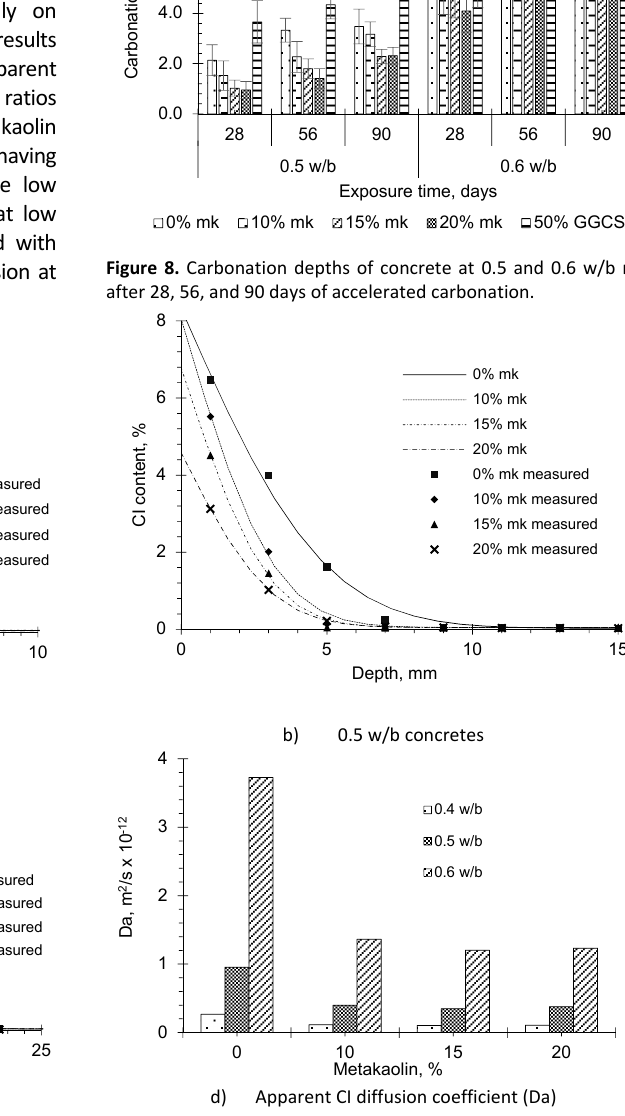
Figure 9. CI diffusion profiles for a) 0.4 w/b, b) 0.5 w/b, and c) 0.6 w/b concretes after 90 days of immersion in NaCl solution, and d) Apparent CI diffusion coefficients of metakaolin concretes at different w/b ratios. Experimental points plotted in a) ‐ c). Note that CI content is presented as a percentage by mass of the total